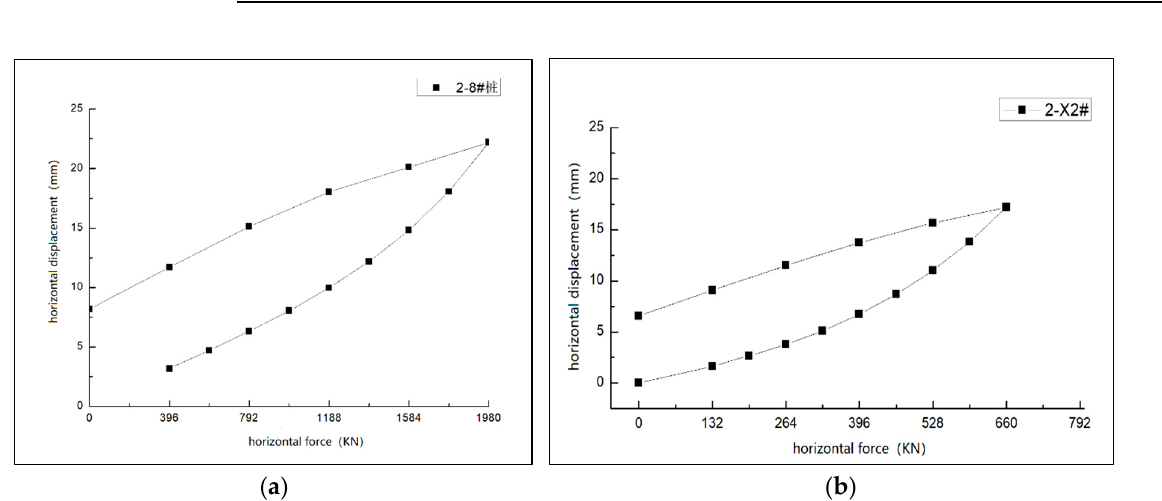
Figure 5. Horizontal force–displacement ( H 0 − x 0 ) curve of: ( a ) 2-8# pile; ( b ) 2-X2# pile.